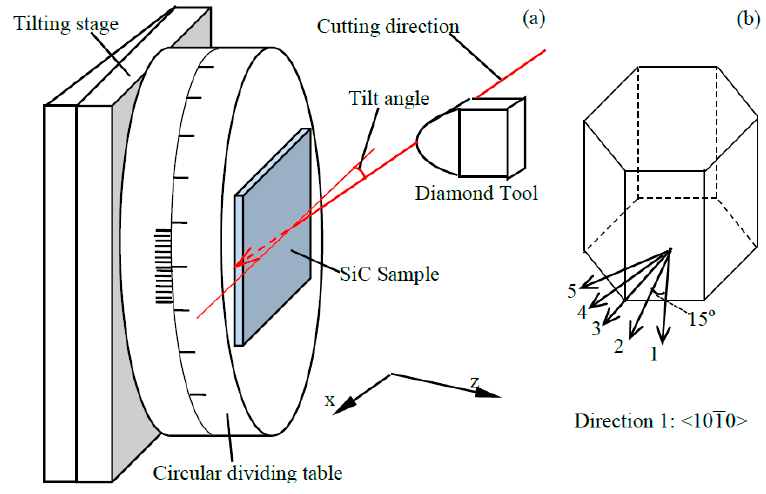
Figure 10. ( a ) Plunge cutting setup and ( b ) cutting directions.